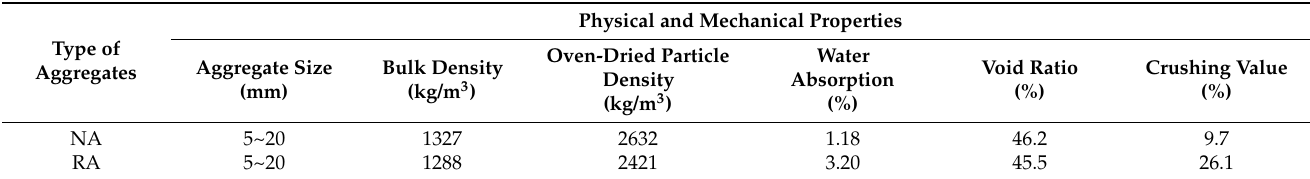
Table 5. Physical and mechanical properties of aggregates.